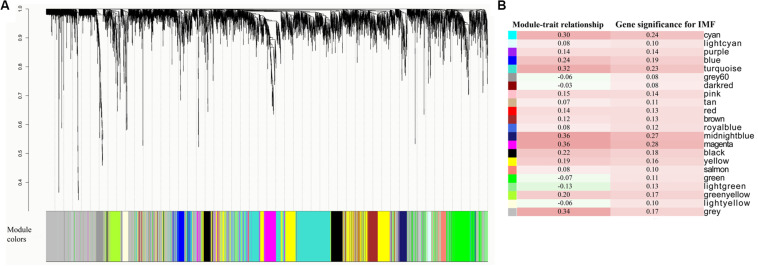
Coexpressed gene modules detected by weighted gene coexpression network analysis (WGCNA). (A) Cluster dendrogram showing the coexpression modules defined by WGCNA and labeled by colors. (B) Module–trait relationships and gene significances of each module.